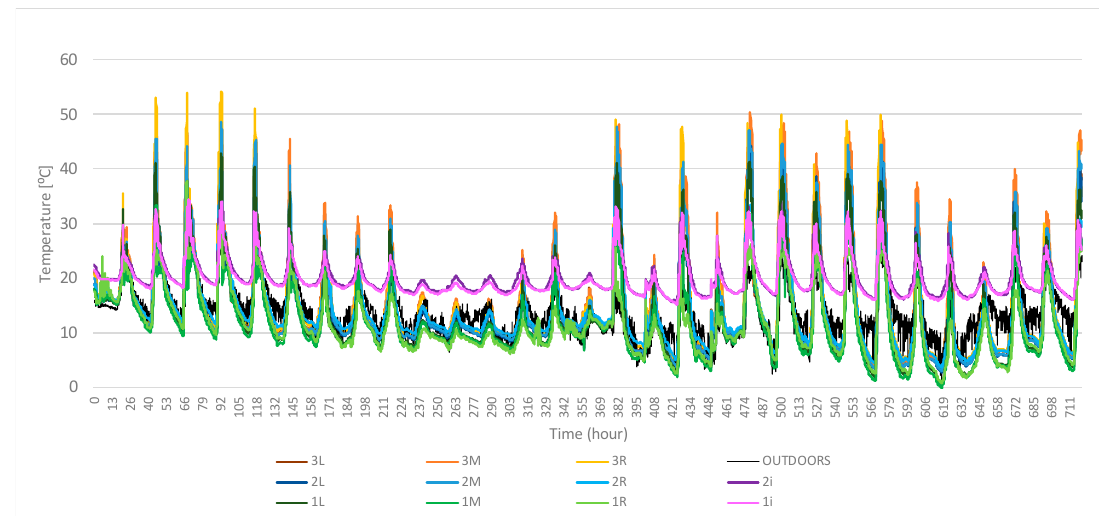
Figure 4. Outdoor, indoor and façade temperatures registered from 5 November to 5 December.